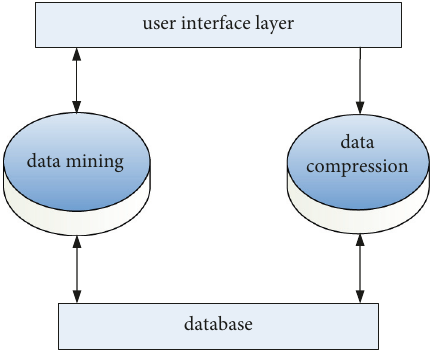
Figure 1: CMining prototype